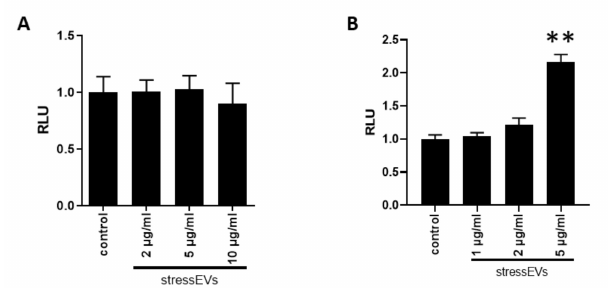
Figure 5. StressEVs do not activate apoptosis or induce cytotoxicity. ( A , B ) Caspase 3 / 7 activity was measured after 4 h incubation of the H9c2 ( A ) or AC16 ( B ) cells with increasing concentrations of stresses. Data were pooled from three ( A ; n = 9; B ; n = 6) independent experiments (** p < 0.01 vs.